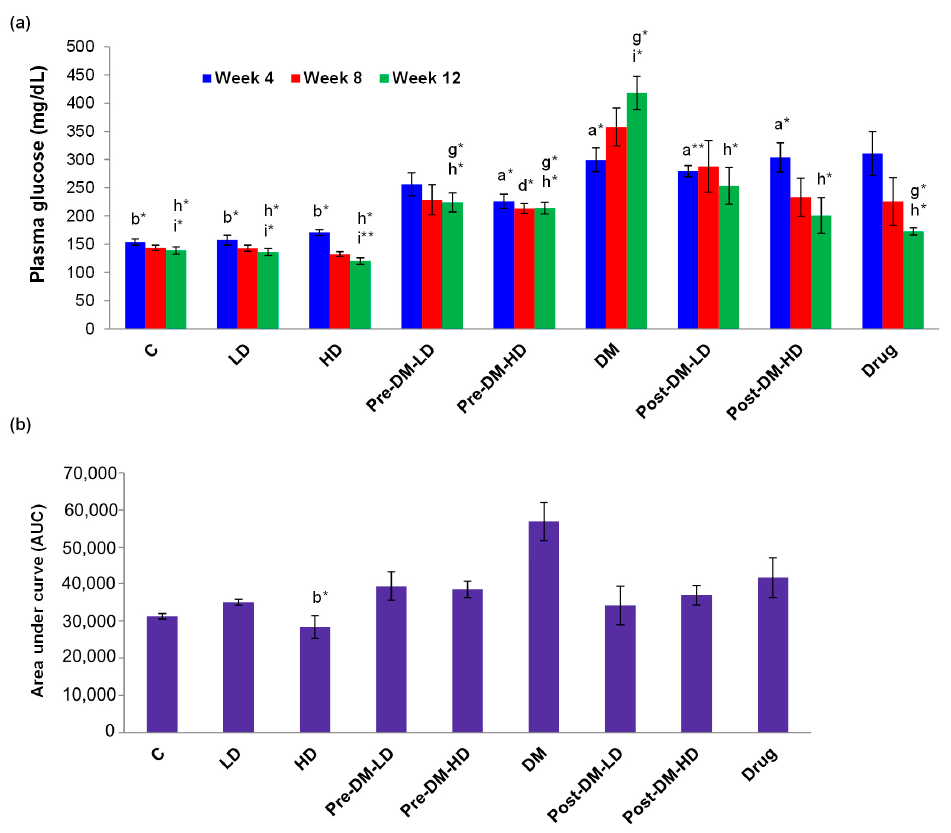
Figure 4. ( a ) Effect of GBRE supplement on the plasma glucose profile of rats during the experimental period. The plasma glucose level of the experimental rats was measured weekly (4, 8, and 12); ( b ) Effect of GBRE supplement on the glucose tolerance of experimental rats. The area under the curve (AUC) for glucose concentrations obtained from the oral glucose tolerance test were calculated using the trapezoidal rule [26]. C: Control, LD: Low dose of GBRE to naïve rat, HD: High dose of GBRE to naïve rat, DM: Diabetes Mellitus induced rat, Pre-DM-LD: Low dose of GBRE to naïve rat and induced DM, Pre-DM-HD: High dose of GBRE to naïve rat and induced DM; Post-DM-LD: Low dose of GBRE to DM rat, Post-DM-HD: High dose of GBRE to DM rat. The significant difference between the groups (a,d,g = when compared with control group; b,e,h = when compared with DM group; c,f,i = when compared with the drug group) were represented as * ( p < 0.05), and ** ( p < 0.01).